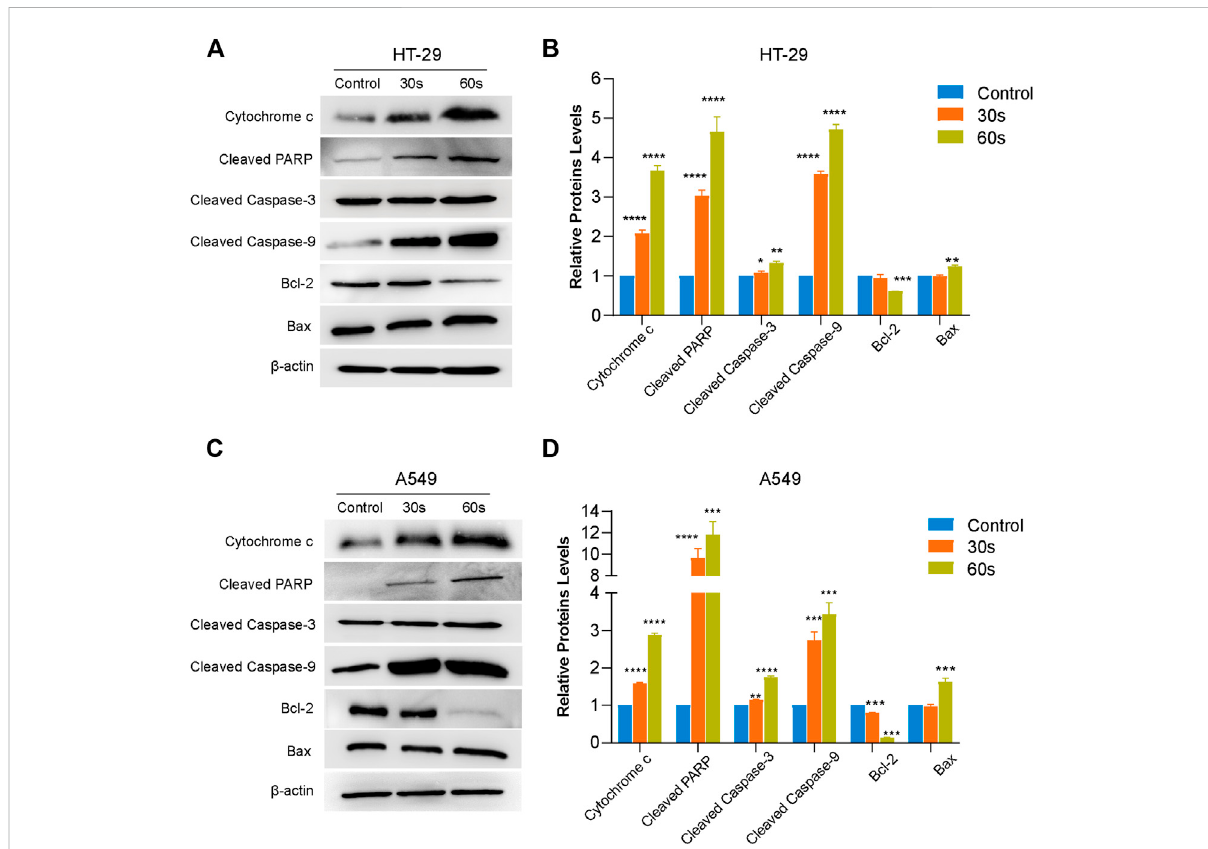
FIGURE 7 Western blot analysis revealing the potential signaling pathway of plasma-induced apoptosis in the HT29 and A549 cells treated using CAP PZ2 . ProteinswereextractedfromtheHT29 (A,B) andA549 (C,D) cellsupontreatmentbyCAP PZ2 for30and60 s,andsubjectedtoWesternblottingusing the respective antibodies with β -actin antibody acting as a parallel blotting.* p < 0.05, ** p < 0.01, *** p < 0.001 and **** p < 0.0001 versus control, n =